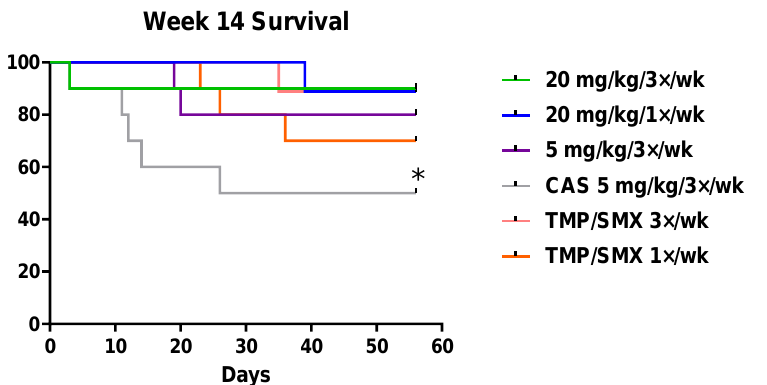
Figure 2. Survival curves for rezafungin and comparators at Week 14 after 56 treatment days of study. CAS = caspofungin; TMP/SMX = trimethoprim/sulfamethoxazole. * Significant difference be- tween rezafungin 20 mg/kg/3×/week (green line) and CAS (grey line) at week 14 ( p < 0.05).